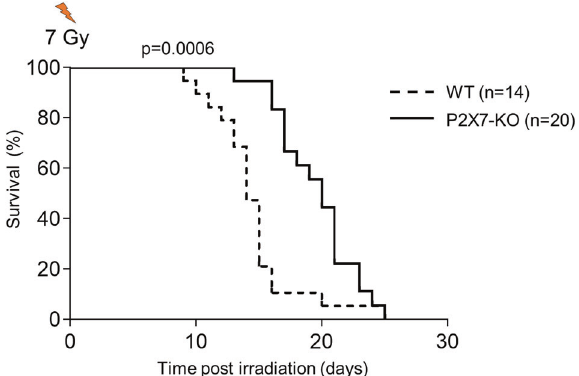
Fig. 6 Role of P2X7 in hematopoietic response to acute irradia- tion. P2X7-KO and WT mice were subjected to whole-body irradiation at the dose of 7 Gy and mouse survival was monitored. A signi fi cant delay in the lethality of P2X7-KO mice relative to WT control mice is observed. Data are from 14 WT and 20 P2X7-KO mice, including males and females sex matched between the genotypes; data are consolidated from two independent experiments; statistical analyses using Log-rank Mantel – Cox test, p =